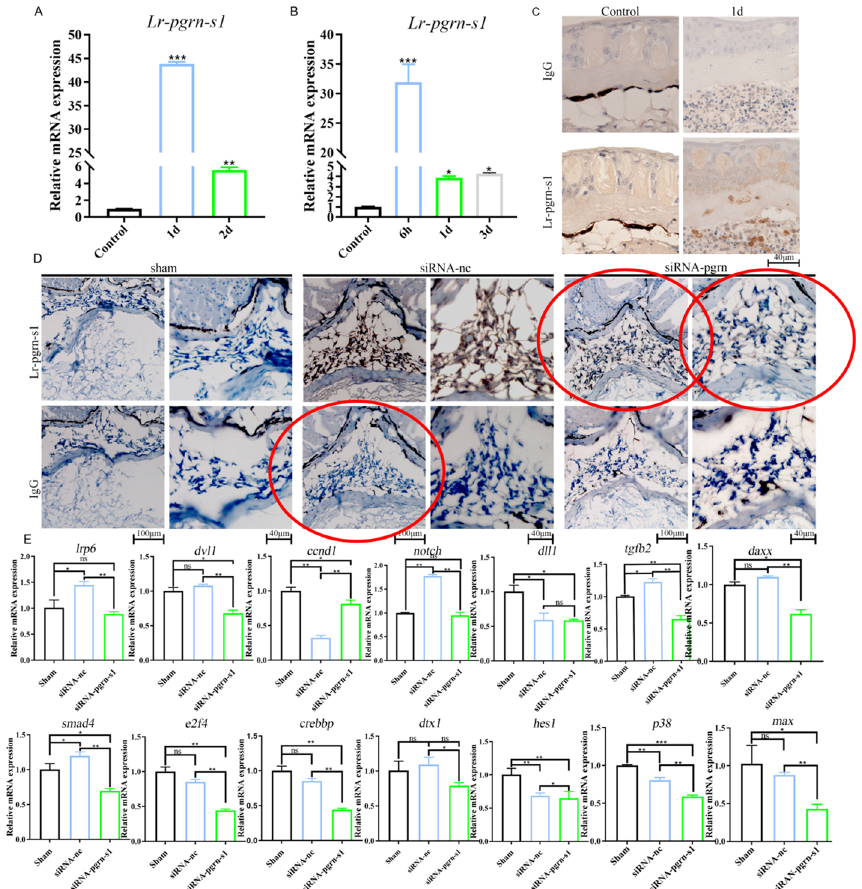
Fig. 5 Expression of Lr-pgrn-s1 after lamprey skin and spinal cord injury. A Expression of Lr-pgrn-s1 in lamprey skin lesions 1d and 2d. B Expression of Lr-pgrn-s1 in lamprey spinal cord injury at 6 h, 1d and 3d by qRT-PCR. C Detection of tissue localization of Lr-PGRN-S1 in skin injury 1d by immunohistochemistry. Take pictures at 40 magnification. D Immunohistochemistry of Lr-pgrn-s1 was knocked down 6 h after lamprey × spinal cord injury. Results under 20 and 40 microscopy in Sham, NC (normal control) and Lr-PGRN-S1 × × groups. E The qRT-PCR analysis of genes in MAPK, Notch, Wnt and TGF-β signaling pathways. The statistical differences between experimental groups were detected by the Student’s t test. All data were presented as the means SDs based on three independent samples with three replicates per sample. ns: non-significant, ± * P < 0.05, ** P < 0.001, *** P <